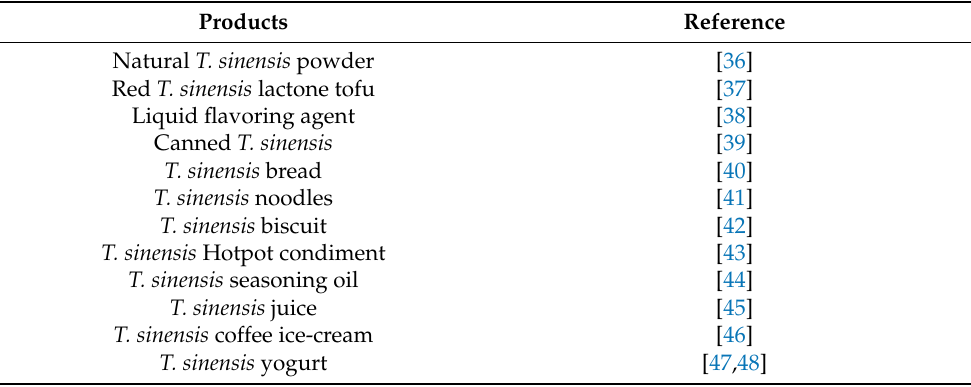
Table 1. Processed products using T. sinensis .